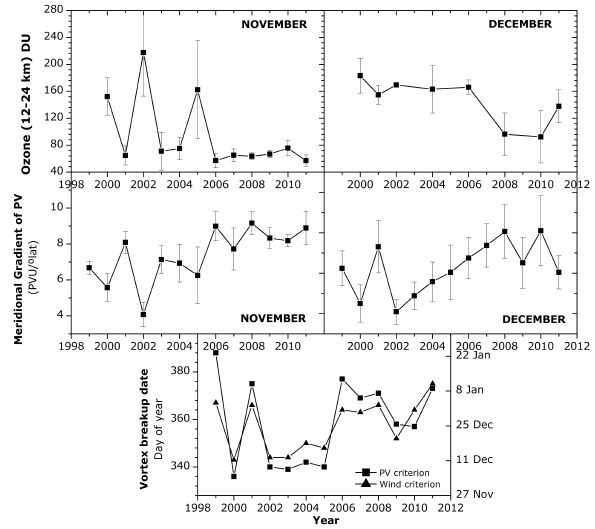
Fig. 10. Top panels show integrated ozone column in the layer 12– 24km in November and December. The vertical error bars indicate Figure 10. Top panels show integrated ozone column in the layer 12-24 km in November and 3 one standard deviation. Middle panels show the mean meridional December. The vertical error bars indicate one standard deviation. Mid-panels show the mean 4 gradient (60–90 ◦ S) of potential vorticity at the isentropic level of meridional gradient (60º-90ºS) of potential vorticity at the isentropic level of 475 K. Lowest 5 475K. The lowest panel presents the day of the final breakdown panel presents the day of the final breakdown of the Antarctic polar vortex from 1999 to 2011 6 of the Antarctic polar vortex from 1999 to 2011 based on Black et based on Black et al., 2006 (squares) and Waugh et al., 1999 (triangles) definitions. 7 al. (2006) (squares) and Waugh et al. (1999) (triangles)